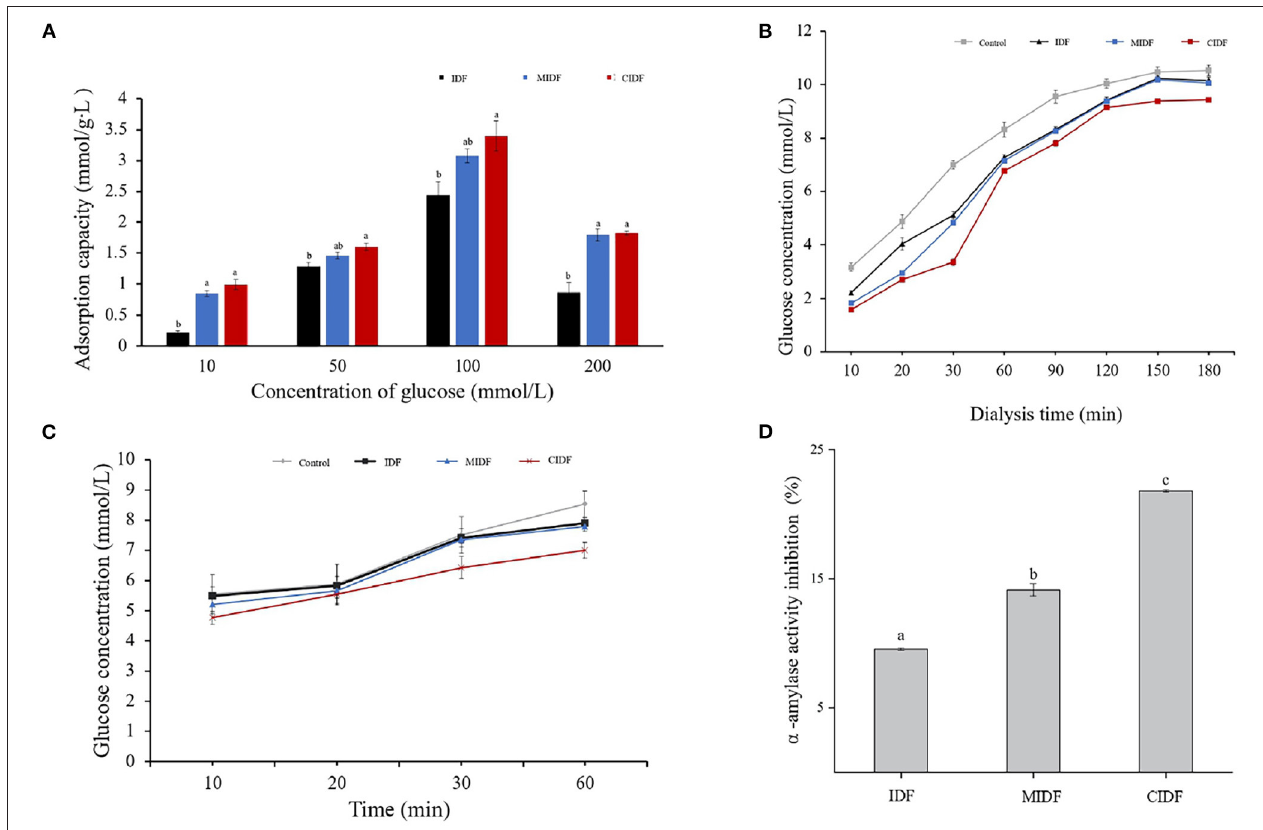
FIGURE 7 | In vitro hypoglycemic properties of IDFs. (A) Glucose adsorption capacity of IDF, MIDF, and CIDF. (B) Glucose diffusion inhibition of IDF, MIDF, and CIDF. (C) Effect on starch digestion of IDF, MIDF, and CIDF. (D) α -amylase activity inhibition of IDF, MIDF, and CIDF.